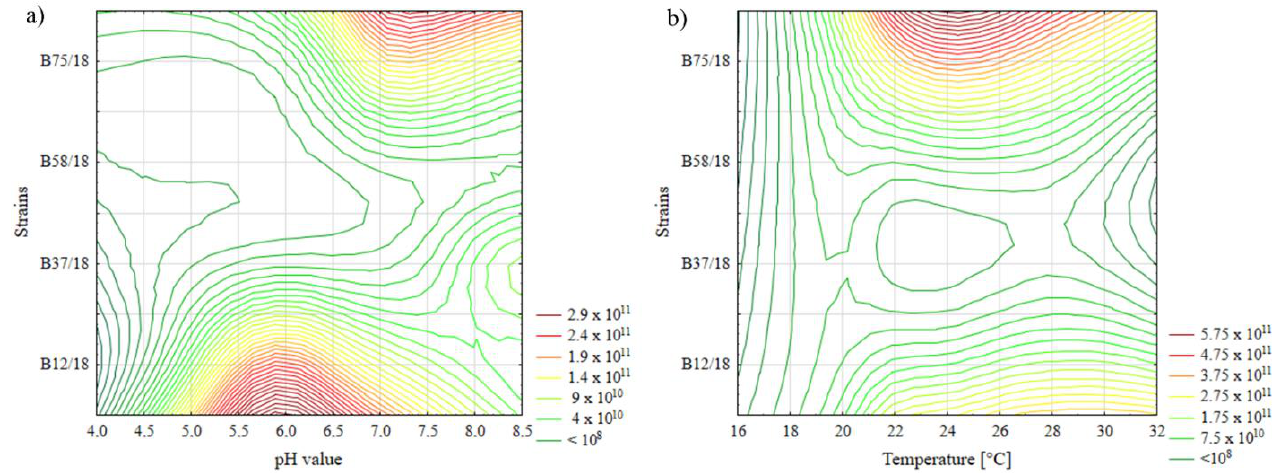
Figure 1. The effect of different medium pH values—( a ) and temperatures—( b ) on the growth of bacteria in a liquid culture. Rhodococcus sp. B12/18, Pseudomonas sp. B37/18, Arthrobacter sp. B58/18, Rhodococcus sp. B75/18.